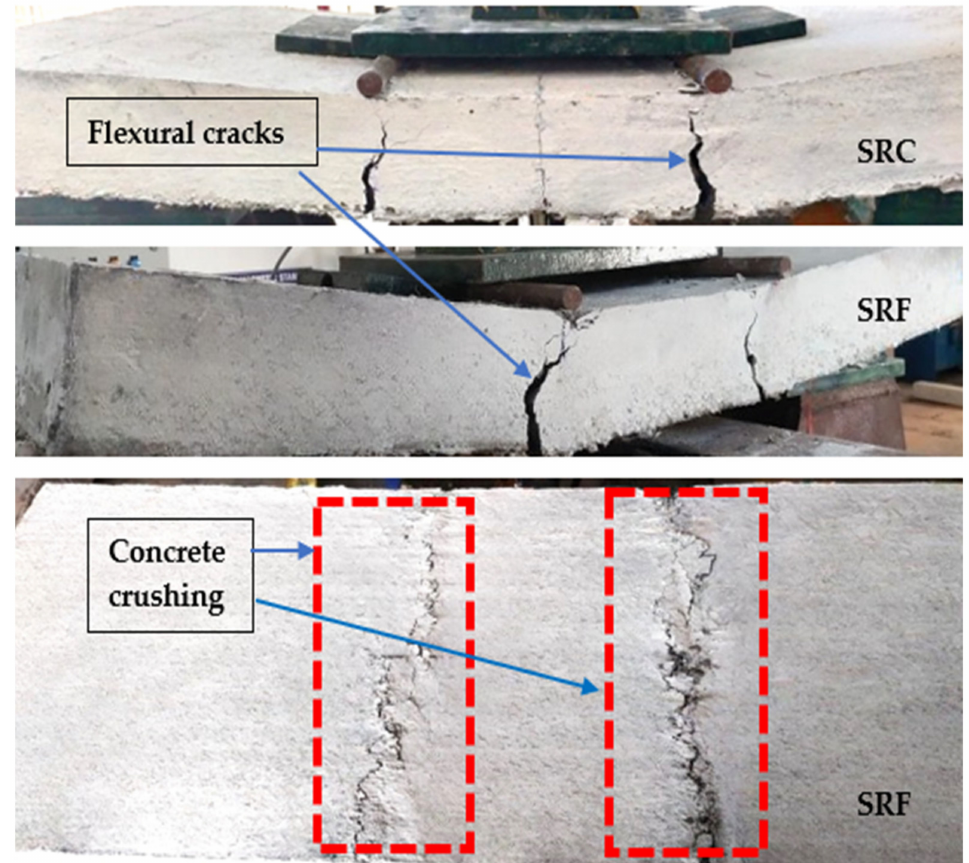
Figure 4. Crack propagation and failure mode of Mode-I slab